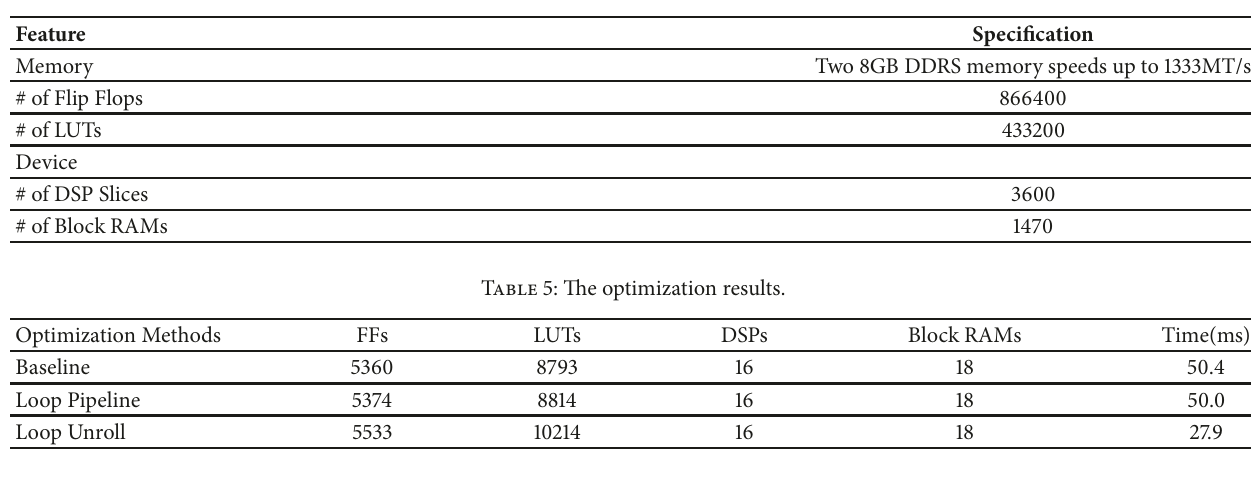
Table 4: Specific parameters of alpha data ADM-PCIE-7V3 FPGA.